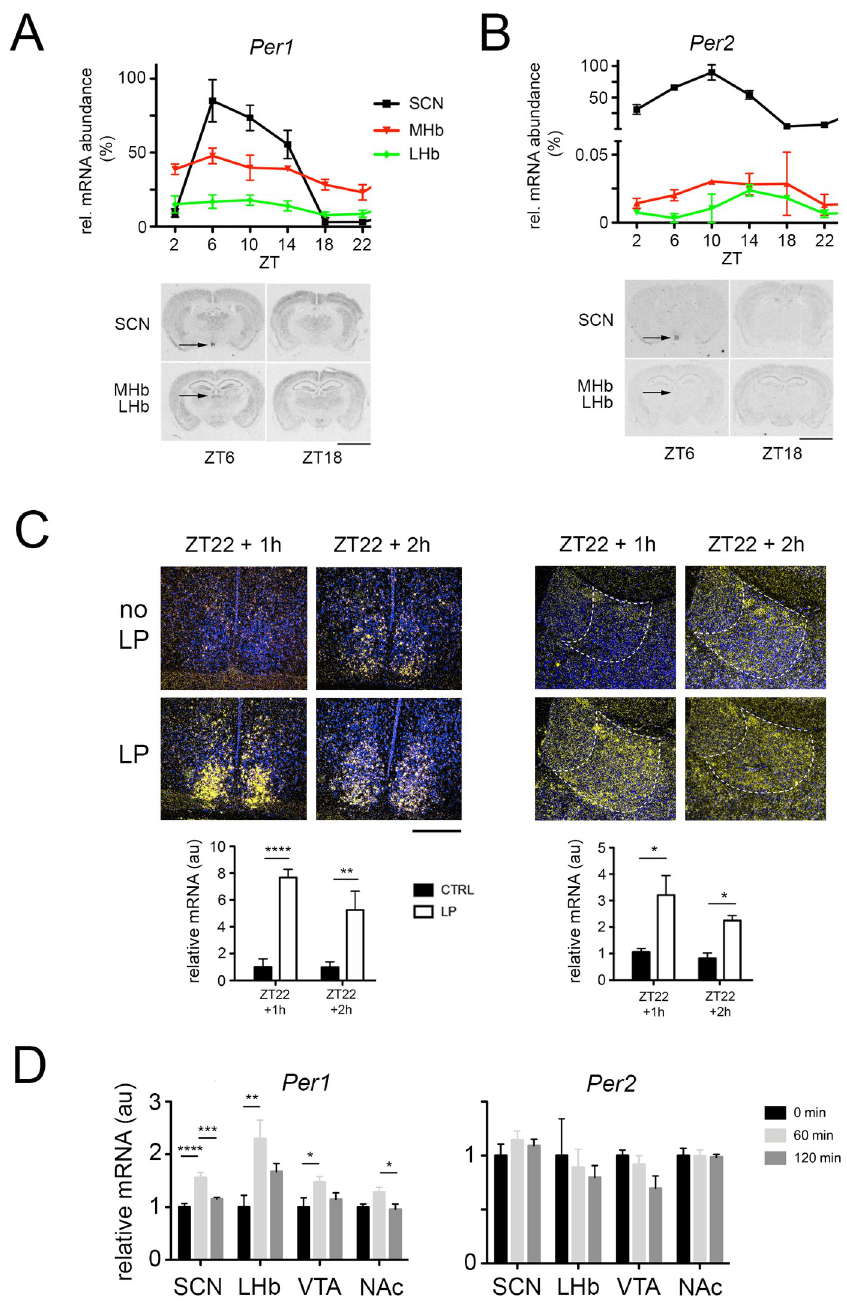
Fig 2. Light induces the clock gene Per1 in the lateral habenula of mice. In situ hybridization revealing expression of Per1 (A) or Per2 (B) in the SCN, the medial habenula (MHb) and the lateral habenula (LHb). The top panel shows the quantification of Per1 expression in the SCN, the MHb and the LHb, values are means ± SEM. CircWave analysis revealed circadian expression of both genes in the tissues shown (n = 3, p < 0.05). The bottom panel shows representative images of brain sections at ZT6 and ZT18 with expression signal (black) of Per1 or Per2 in the respective brain regions. Scale bar: 5 mm. (C) Induction of Per1 mRNA expression after a LP at ZT22 in the SCN (left panels) and in the lateral habenula (right panels). The blue color depicts cell nuclei (Hoechst staining) and the yellow color shows radioactively labeled antisense Per1 riboprobe hybridized to Per1 mRNA. Below the photo-micrographs quantification is shown. Two-way ANOVA with Bonferroni multiple comparisons test, n = 3, � p < 0.05, �� p < 0.01, ���� p < 0.0001, values are means ± SEM. Scale bar = 200 μ m. (D) Quantitative PCR revealed mRNA expression levels of Per1 (left panel) and Per2 (right panel) in the suprachiasmatic nuclei (SCN), lateral habenula (LHb), ventral tegmental area (VTA) and nucleus accumbens (NAc) after 60 min. (light grey bars) and 120 min. (dark grey bars) of a light pulse